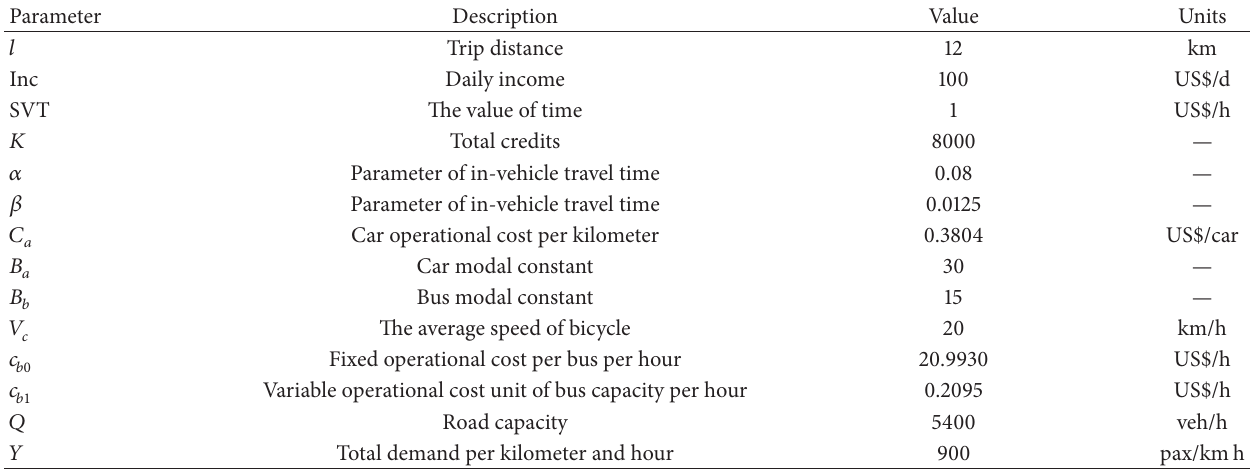
Table 1: Parameter values used in numerical analysis.